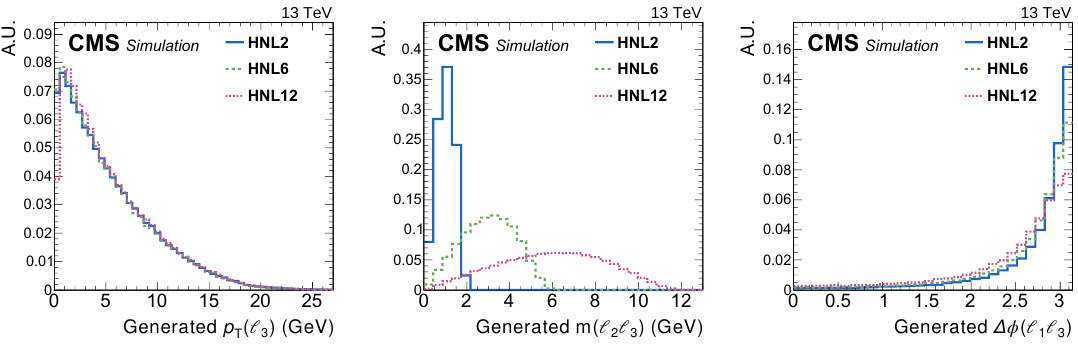
Figure 2 . Distribution of kinematic properties of the generated leptons for simulated HNL signal events: the p of ‘ (left), the m ( ‘ ) variable (center), and the angular separation between ‘ ‘ T 3 2 3 (right). Predictions are shown for several benchmark hypotheses for Majorana HNL production: ‘ 3 = 2 GeV and | V = 6 GeV and | V m | 2 = 1 . 2 × 10 − 4 (HNL2), m N N ‘ N = 12 GeV and | V m | 2 = 1 . 0 × 10 − 5 N N ‘